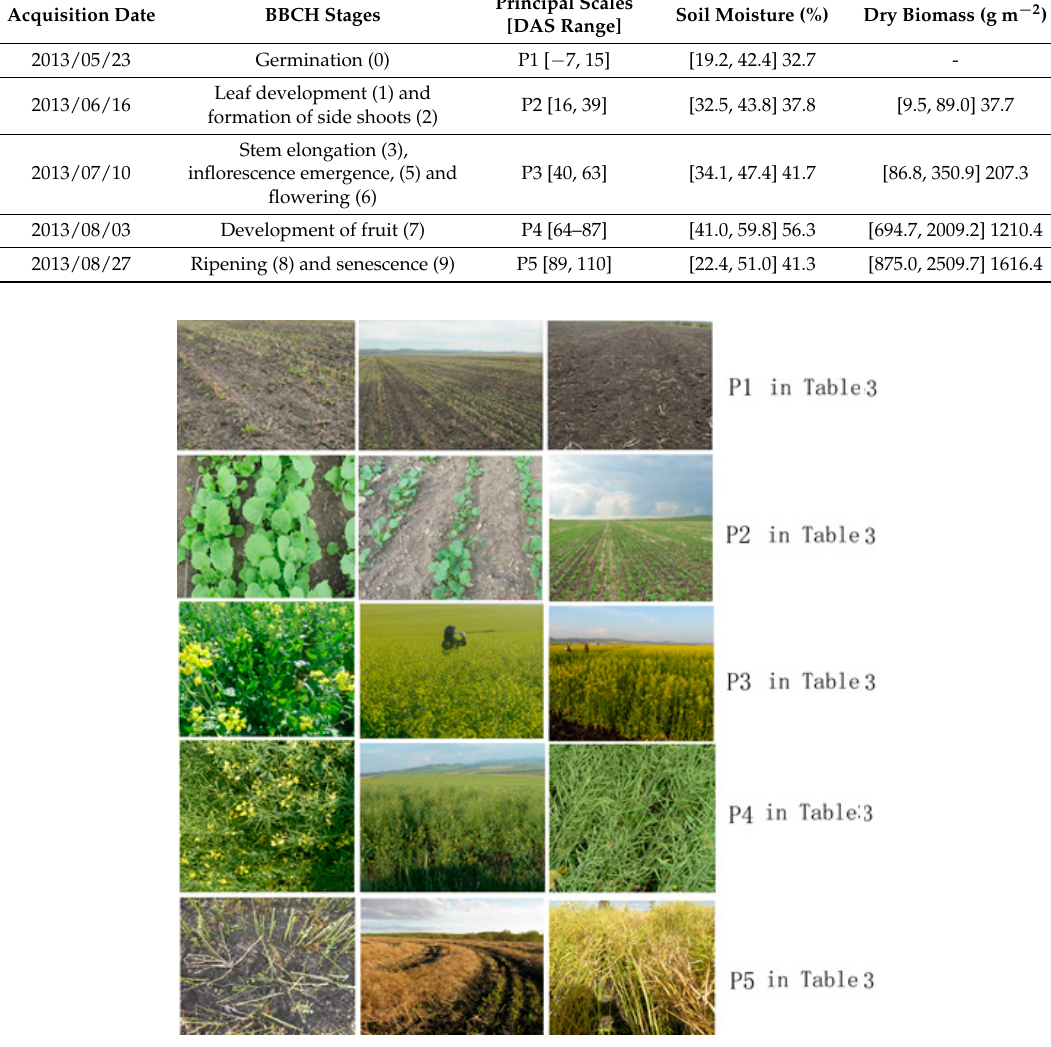
Figure 4. Typical oilseed rape fields at different growth stages. The text on the right of each line is their stage value.